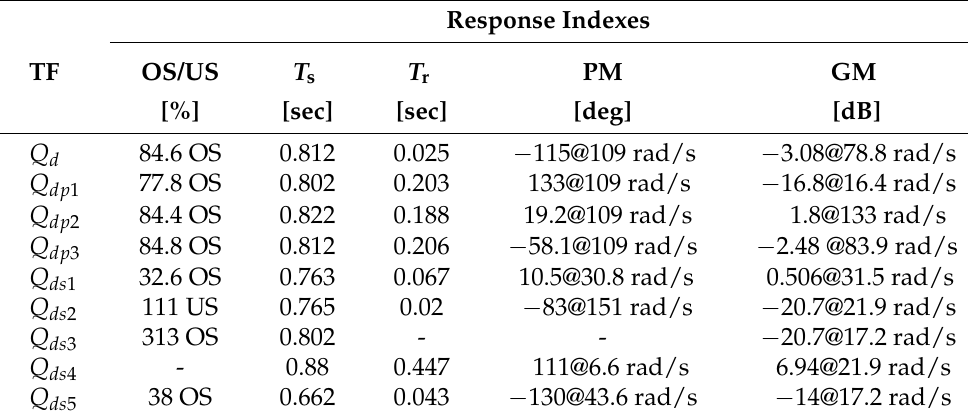
Figure 3. Step response comparison of model simplifications for the pitch rate transfer function Q d . Table 1. Q d (no controller included yet) model representation